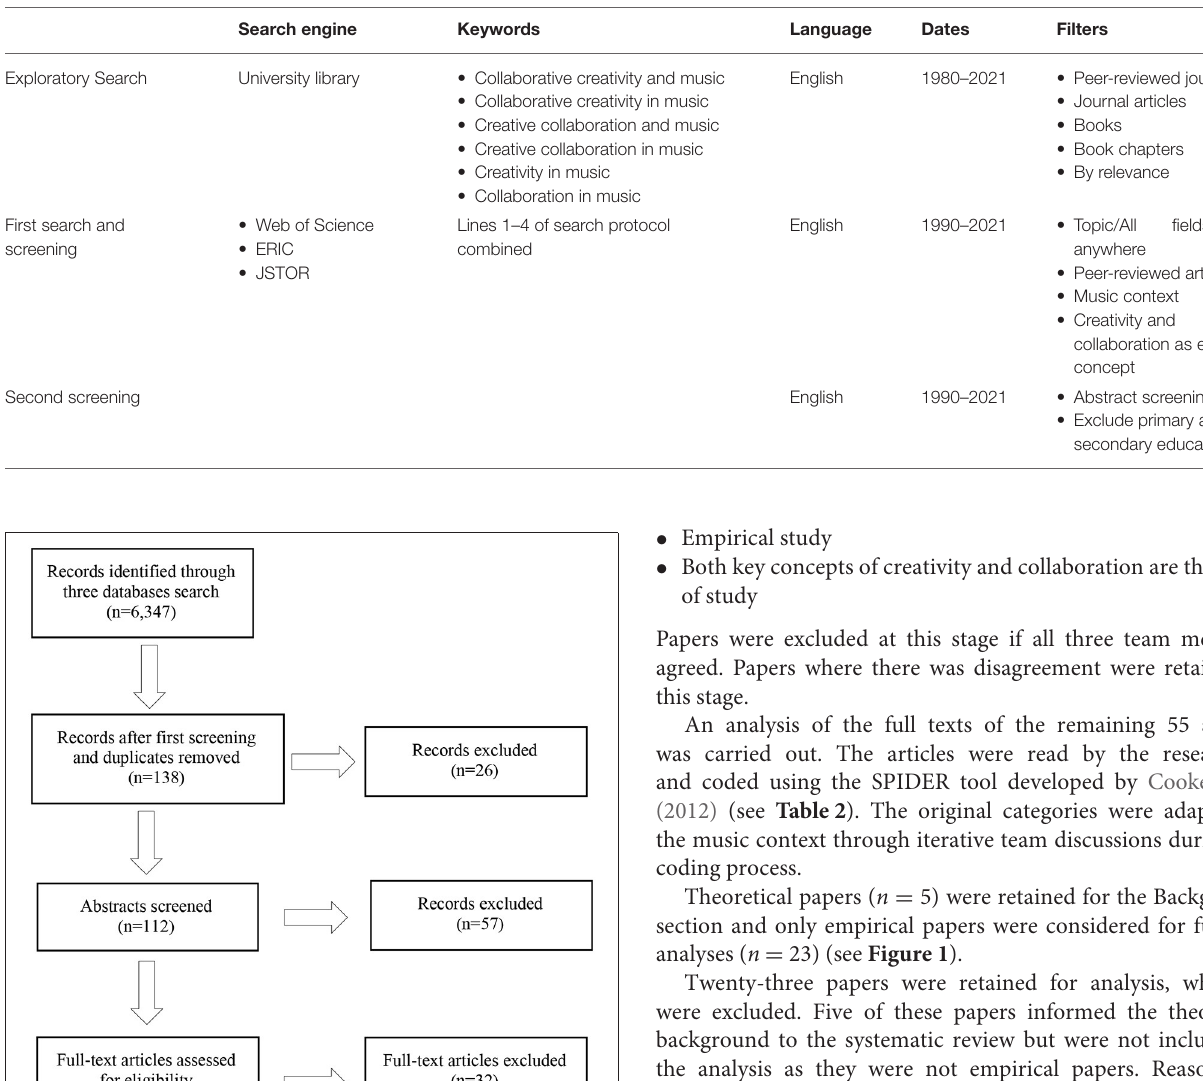
TABLE 1 | Screening criteria.